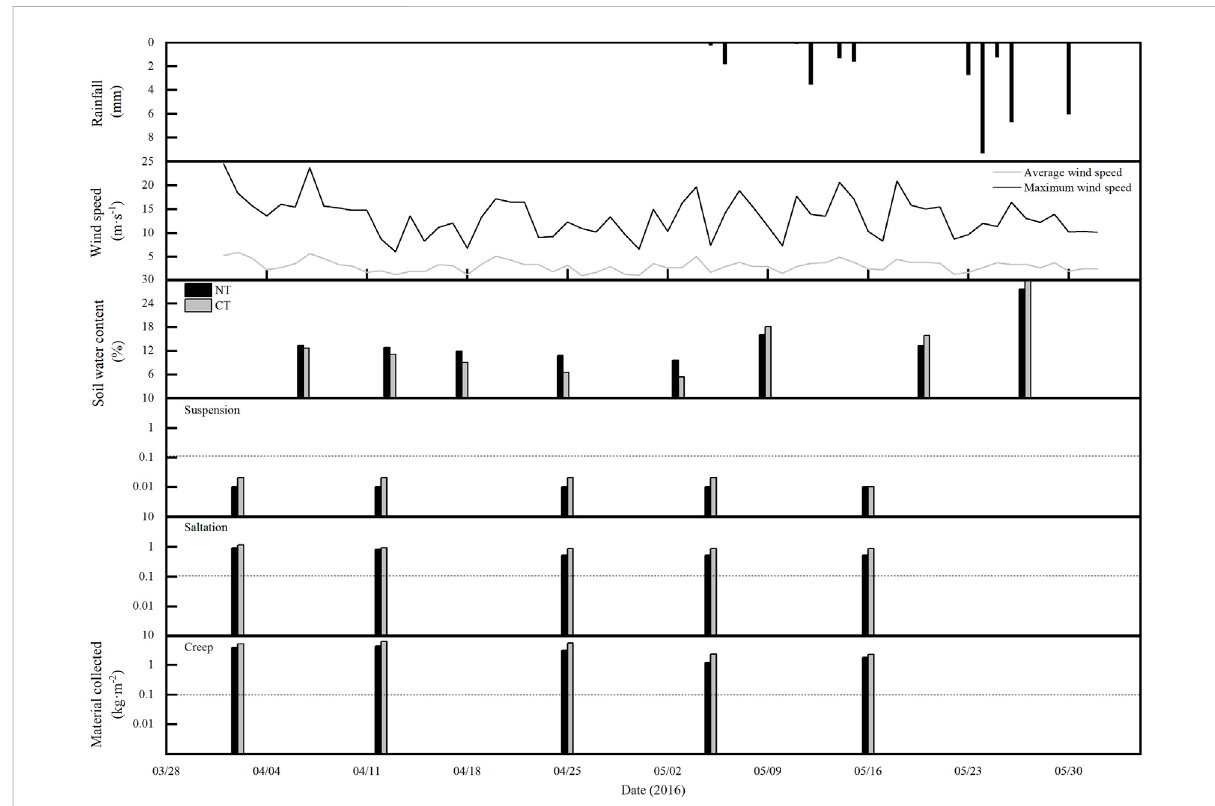
FIGURE 6 Rainfall, average windspeed, maximum windspeed, soil water content,and erodible particles (creep, saltation, and suspension) underdifferent tillage treatment over the period from 1st April to 1st June (2016 –